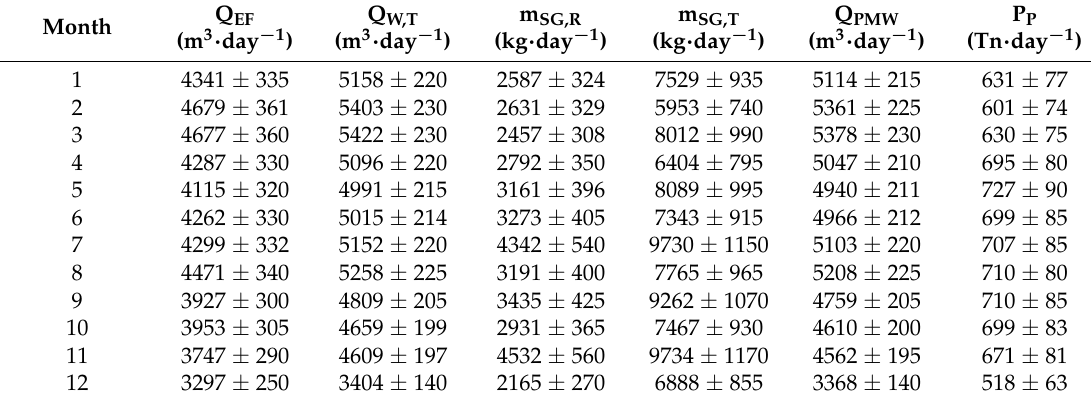
Table 2. Characterization of water and sludge flows of the wastewater treatment plant, and water consumption and paper production of the paper mill. Q EF (volumetric flow of treated water), Q W,T (volumetric flow of total water consumed during the paper manufacturing process), m SG,R (mass flow of recovered sludge), m SG,T (mass flow of generated sludge), Q PMW (volumetric flow of wastewater from paper mill), P P (mass flow of paper produced).